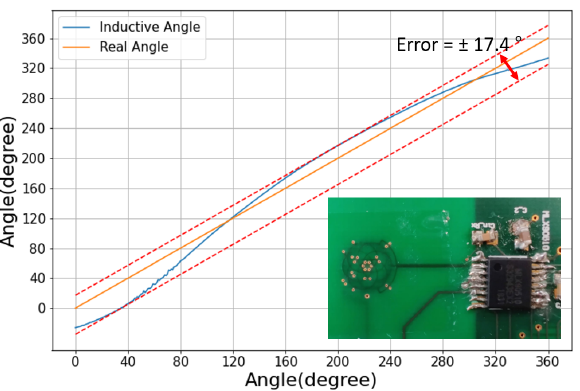
Figure 13. Angle response curves for the chip-scale miniaturized inductive sensor. The inset shows a picture of the chip-scale coil system and the interface chip in a TSSOP16